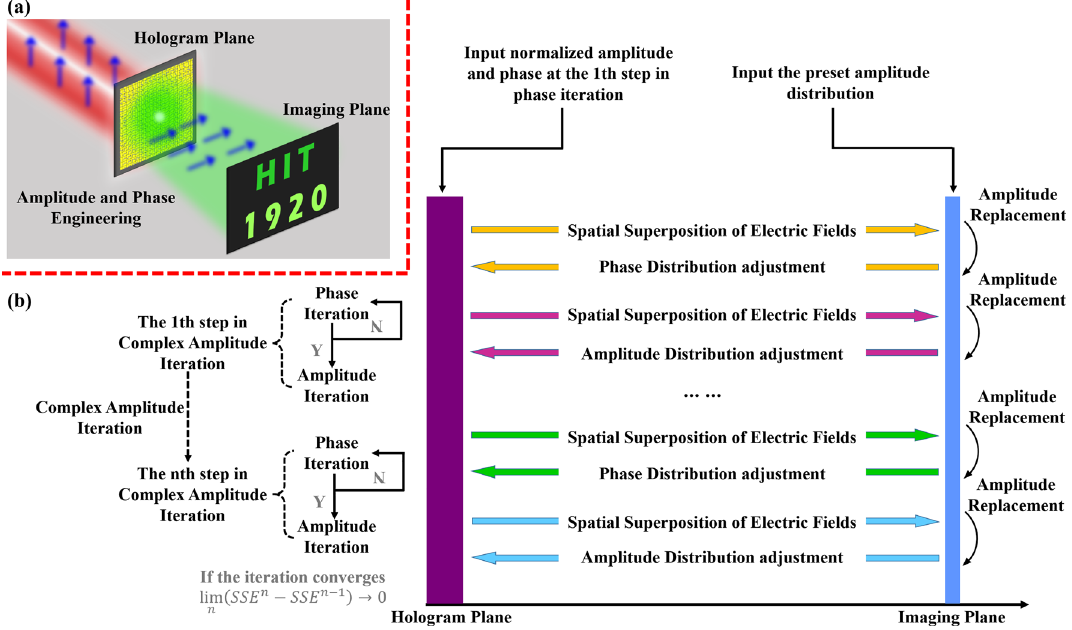
Figure 1: Schematic diagram of the proposed complex-weighted Gerchberg – Saxton (CGSW) and complex-amplitude holograms. (a) The schematic representation of the proposed large field-of-view (FOV) complex-amplitude metasurface hologram. (b) The principle of the proposed CGSW.The input information includesthe amplitudeof eachdiscretepoint constituting the preset image andthe initial valueof the amplitude and phase in the hologram plane used as the initial value of the first phase iteration. The complex amplitude iteration can be decomposed into two processes of amplitude iteration and phase iteration, wherein the amplitude initial value or phase initial value used in the phase iteration or amplitude iteration is the final value obtained in the previous iterative process and remains unchanged during the iterative